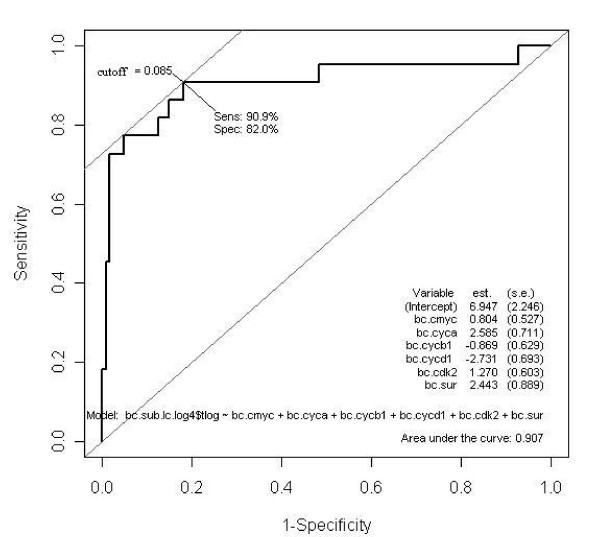
ROC Curve Based on Stepwise Multiple Logistic Regression and Log Transformed Biomarkers to Classify Cancer/No Cancer (no nodules, solid nodules, and ground glass opacities groups).